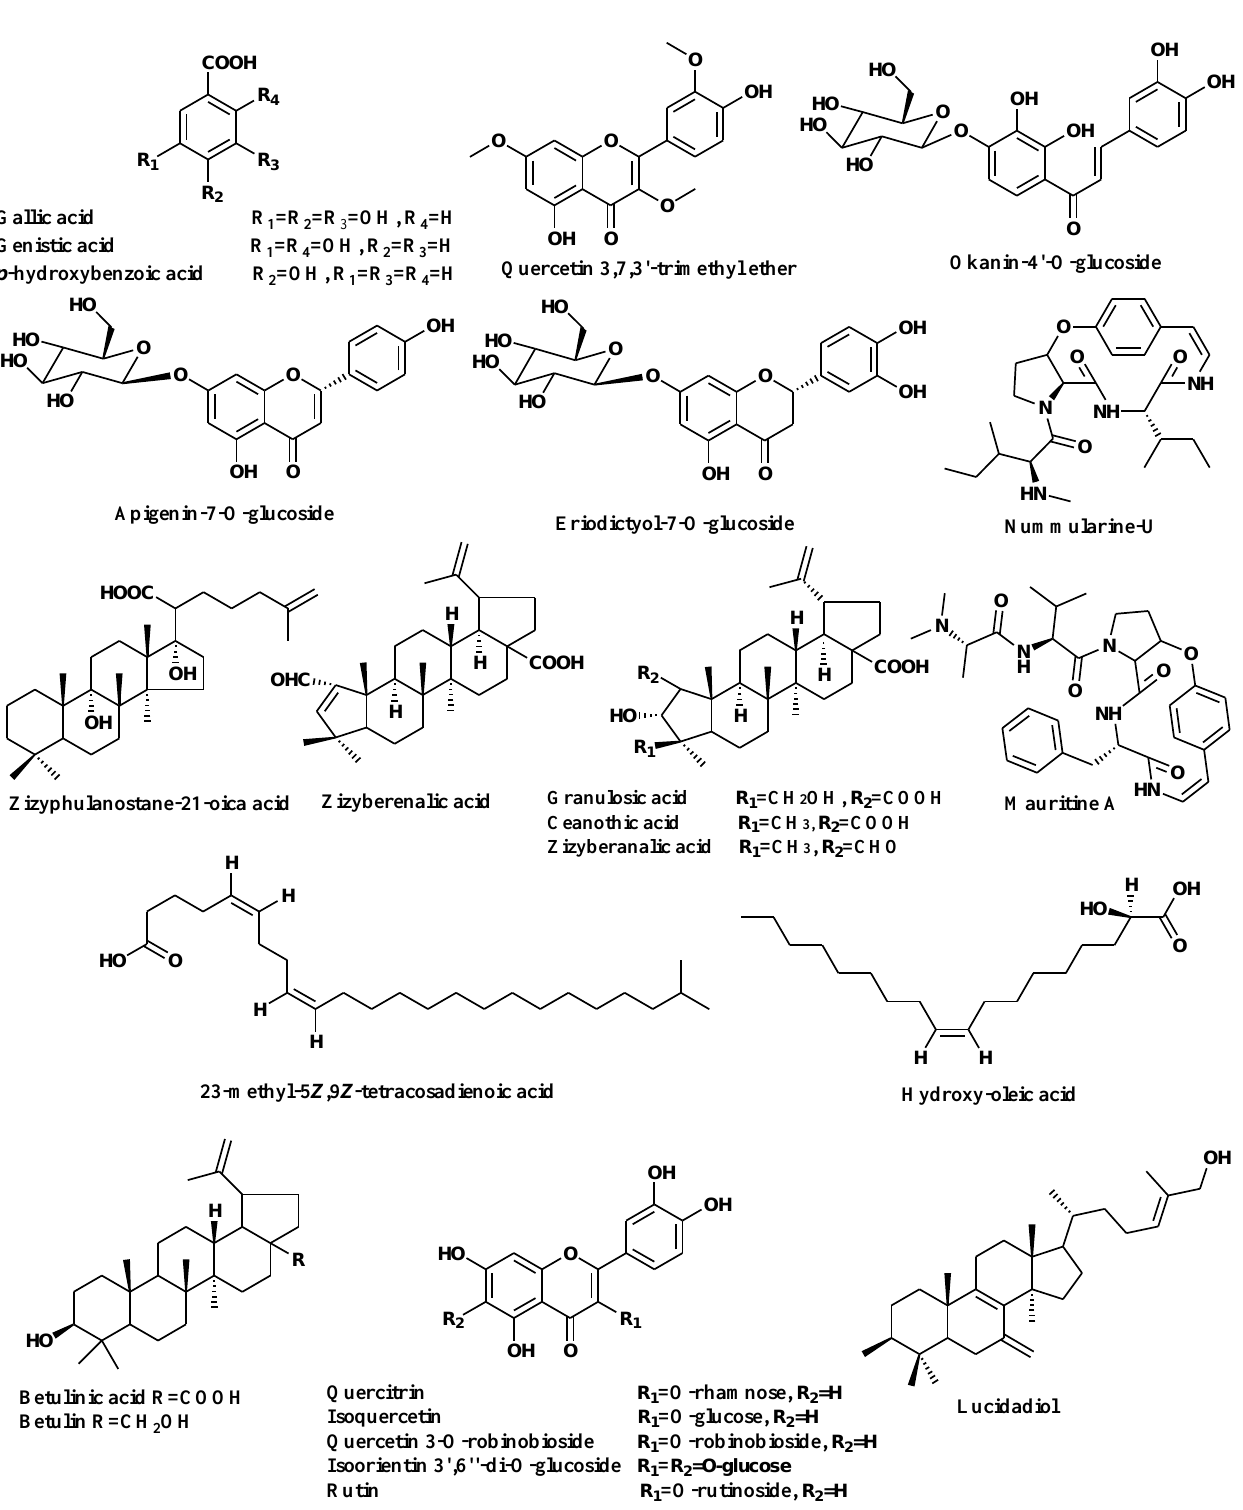
Figure 2. Major compounds identified in Z. spina-christi L. stem bark different fractions (total ethanol extract, diethyl ether, n -butanol) using HPLC-ESI-MS.